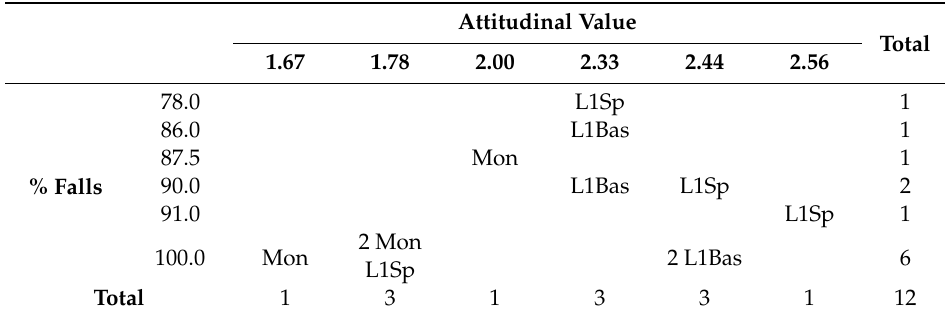
Table 10. Percentage of interrogative sentences ending in falling contours according to attitudinal value and speakers’ language profile.